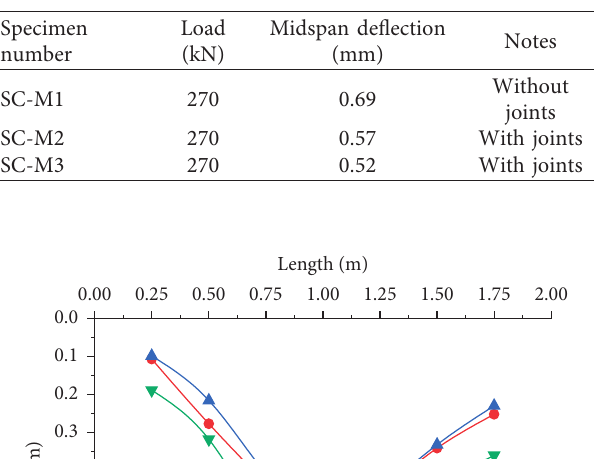
Figure 13: Load-mid-span deflection relationship of flexural specimens. Table 1: Midspan deflection of flexural specimens.